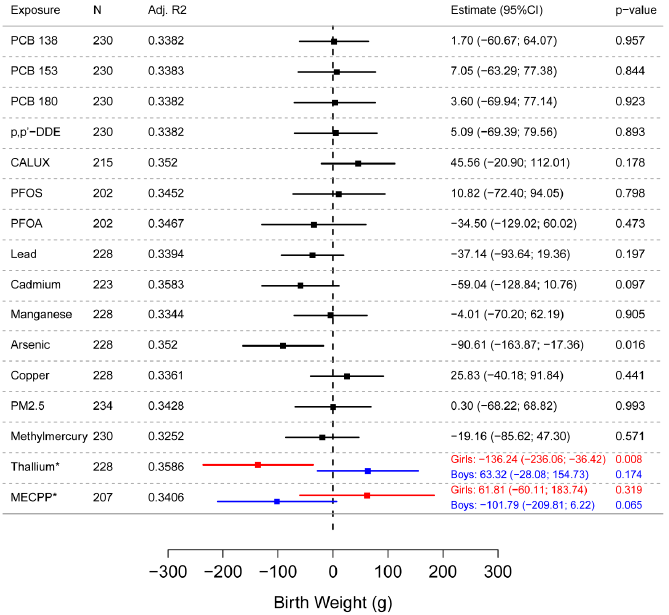
Figure 2. Association between maternal exposure and birth weight based on single pollutant regression models. The estimated effects (for an increase of the Z-score of the exposure biomarker with the interquartile range) and corresponding confidence limits (95%) are shown by squares and lines, respectively. Significance (at the 5% level) is demonstrated when the confidence interval does not include 0. The models are adjusted for gestational age, child’s sex, smoking of the mother during pregnancy, parity and maternal prepregnancy BMI. * For thallium and MECPP effect modification by sex was observed. A separate estimate was calculated for boys (blue) and girls (red). N = Number of samples; Adj. R 2 = Adjusted R 2 . Int. J. Environ. Res. Public Health 2016 , 13 , 495